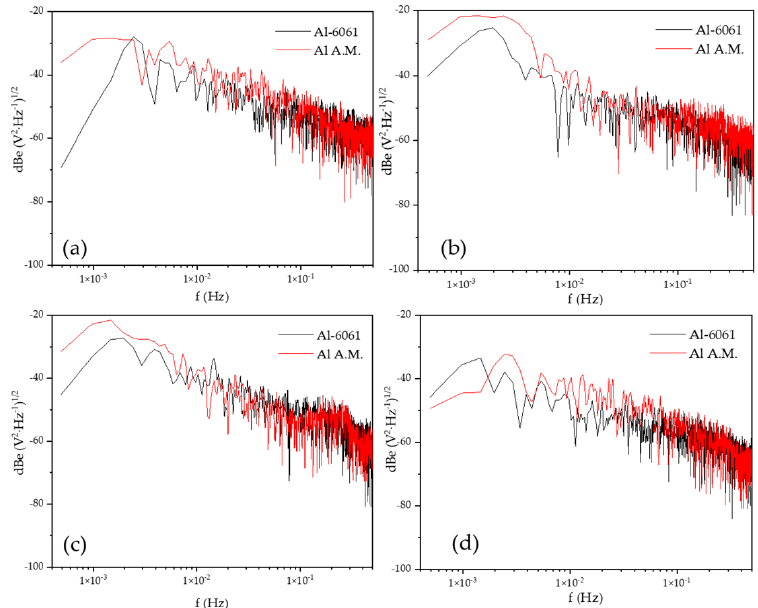
Figure 6. Power spectral density (PSD) of voltage in H 2 O solution, ( a ) 0 h, ( b ) 24 h, ( c) 48 h, and ( d ) 120 h. Table 5. Parameters obtained by PSD for the Al-6061 alloy.